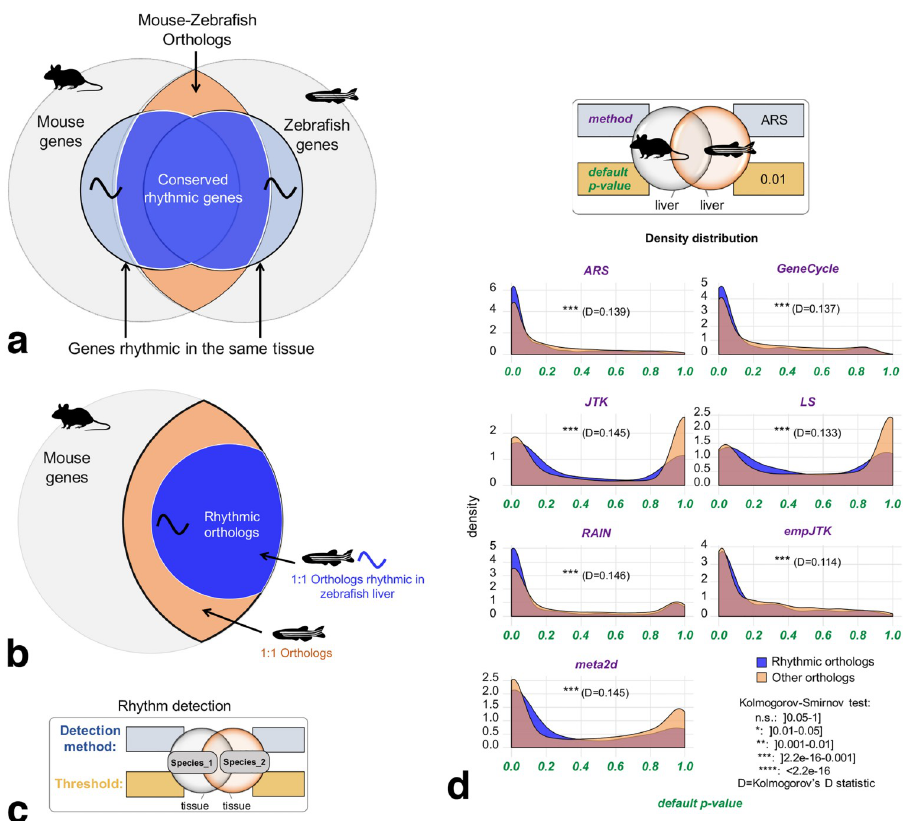
Fig 5. Signal of evolutionary conservation of rhythmic gene expression. Orthologous genes detected as rhythmic in the same organ of two species have a stronger statistical signal of rhythmicity than those not detected as rhythmic in at least one species. a) Mouse and zebrafish share orthologous genes, some of which are rhythmic in the homologous tissues. b) Method used for ortholog benchmarking, as in panel d : From all mouse genes, only mouse-zebrafish one-to- one orthologs are kept. Considering the liver, these orthologs are separated into two groups: genes for which the ortholog is detected as rhythmic in zebrafish liver, called rhythmic orthologs; and the remaining one-to-one orthologs. c) Chart providing the legends to inform about the method and the threshold used to call genes rhythmic for each condition (species and tissue). d) p -values density distribution of rhythmic orthologs vs non-rhythmic orthologs obtained for the seven methods applied to mouse liver data. Mouse-zebrafish orthologs, that are detected rhythmic in zebrafish liver, are significantly more enriched in small p -values in mouse liver, for all methods (Kolmogorov-Smirnov test p -values < 0.001). Images credit: Anthony Caravaggi (mouse), Ian Quigley